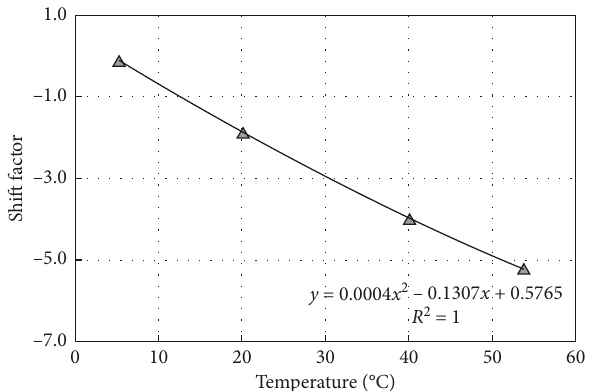
Figure 5: Shift factor of the tested dynamic modulus.